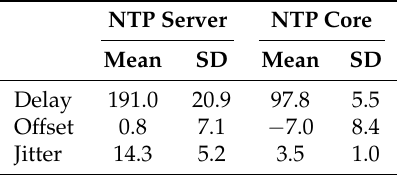
Table 9. Accuracy parameters statistics ( µ s).